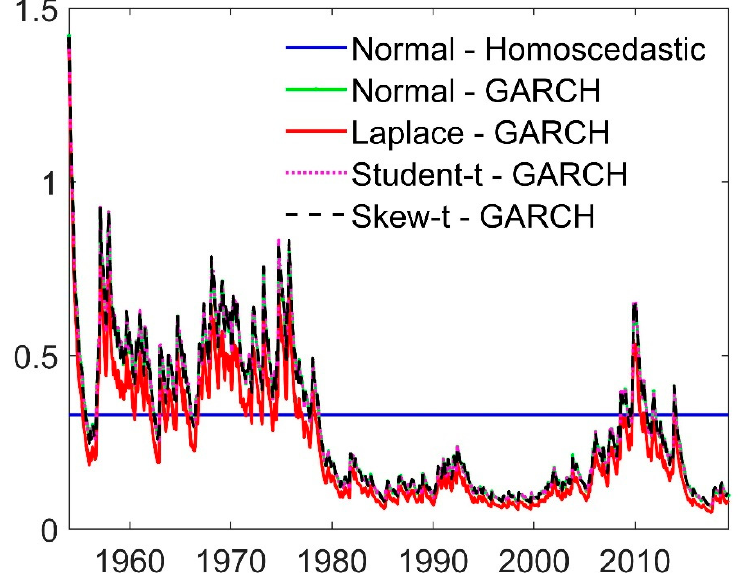
Figure 4. Conditional volatility under different assumptions for the error term. Note: Conditional standard deviation on vertical axis.